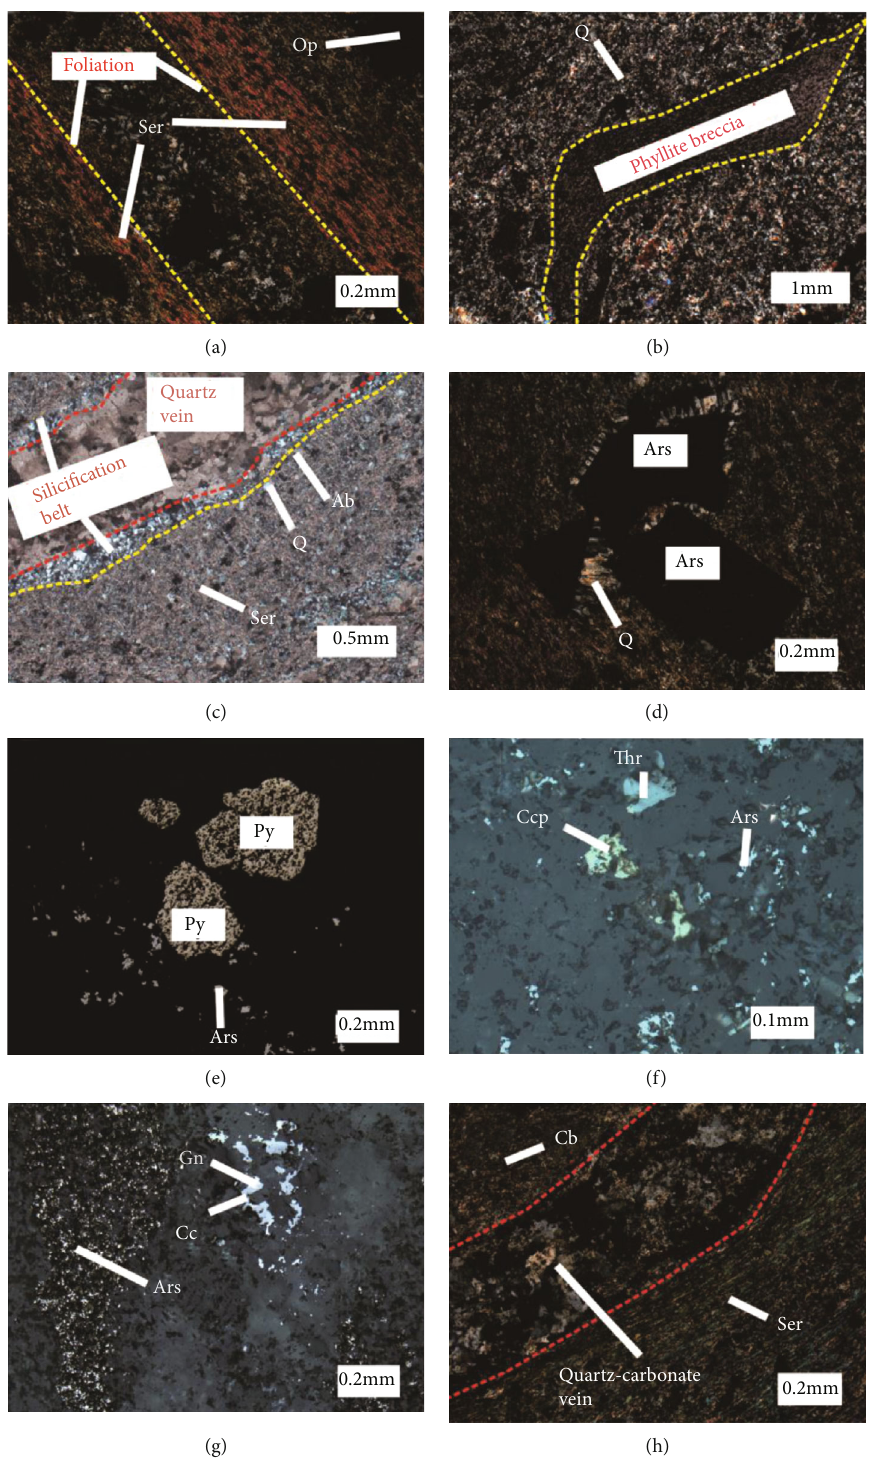
Figure 4: Photomicrographs and microstructures of the Daping gold deposit. (a) The schistose foliation formed by the orientation of sericite (cross-polarized light). (b) Tensile ductile deformation of the phyllite breccia (cross-polarized light). (c) The silici fi cation belt around the quartz vein (plane-polarized light). (d) The pressure shadow (recrystallized quartz) formed by the arsenopyrite (cross-polarized light). (e) The quartz vein containing hypidiomorphic pyrite and xenomorphic arsenopyrite of the fi rst stage of the metallogenic period (re fl ected light). (f) The quartz vein containing mineral assemblages of xenomorphic arsenopyrite, chalcopyrite, and tetrahedrite of the second stage of the metallogenic period (re fl ected light). (g) The quartz-carbonate vein of the third stage of the metallogenic period (cross- polarized light). Mineral abbreviation: Py: pyrite; Ars: arsenopyrite; Cc: chalcocite; Gn: galena; Ccp: chalcopyrite; Thr: tetrahedrite; Q: quartz; Ser: sericite; Ab: albite; Cb: carbonate mineral; Op: opaque